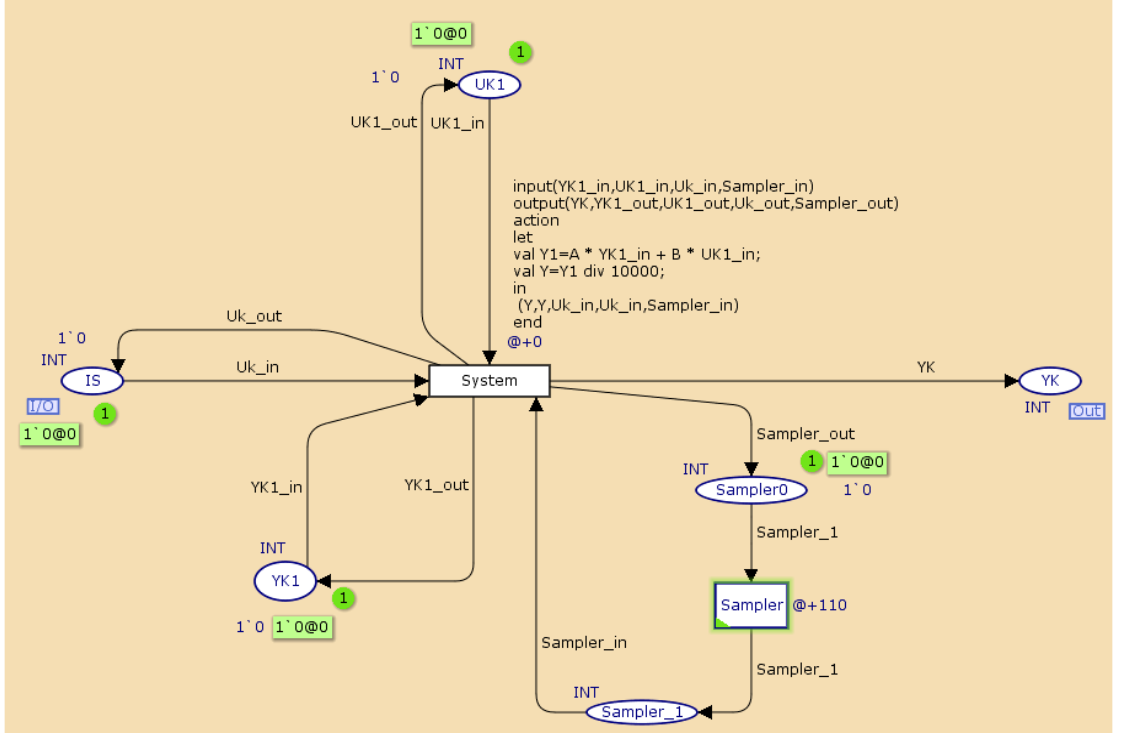
Figure 9. CPN model for the control system.